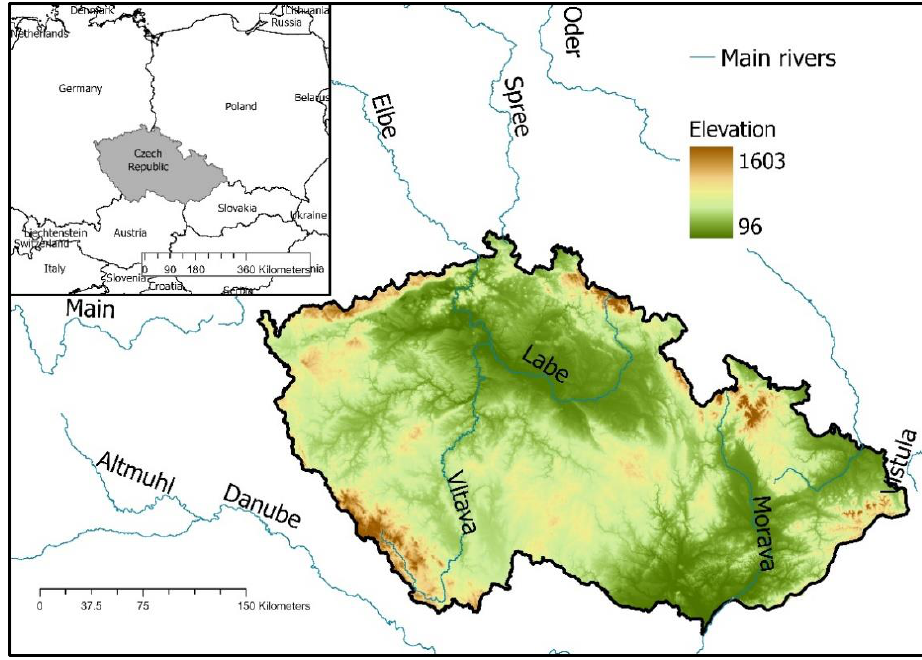
Figure 1. Study area of the Czech Republic with elevation model (CUZK — Zabaged ® ).